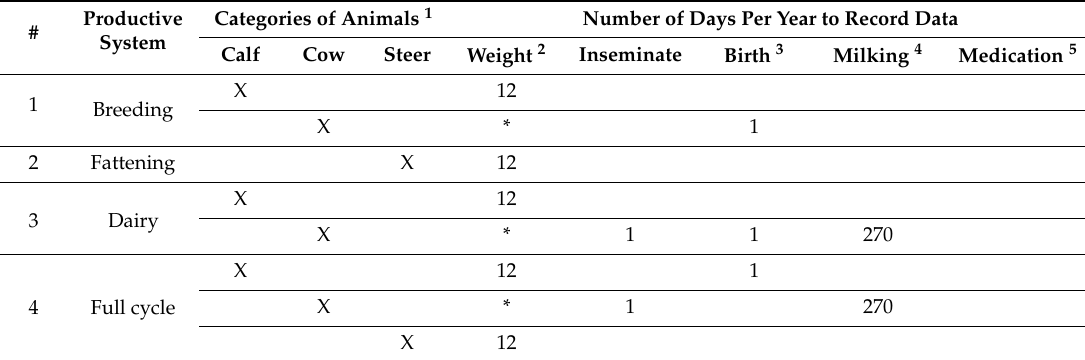
Table 4. Categories of animals and number of days to record data according to the productive